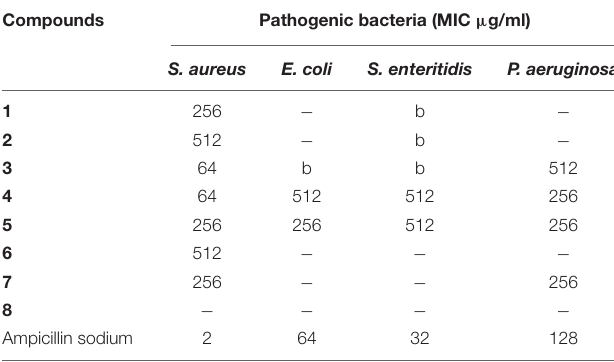
TABLE 5 | Antibacterial activity of compounds 1–8 and ampicillin sodium.